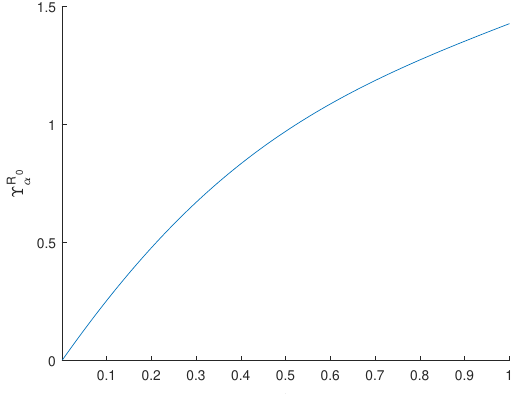
Figure 6. The sensitivity of Model (2) with respect to the fractional order of differentiation α , in agreement with Definition